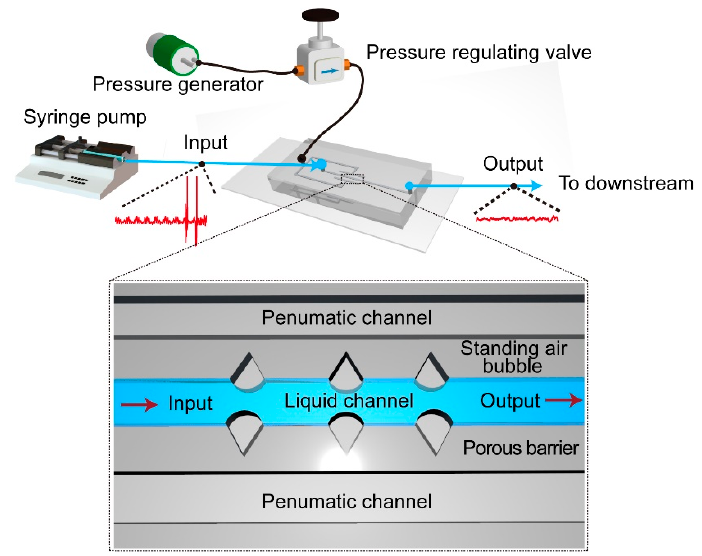
Figure 1. Schematic illustration of the bubble-based microfluidic